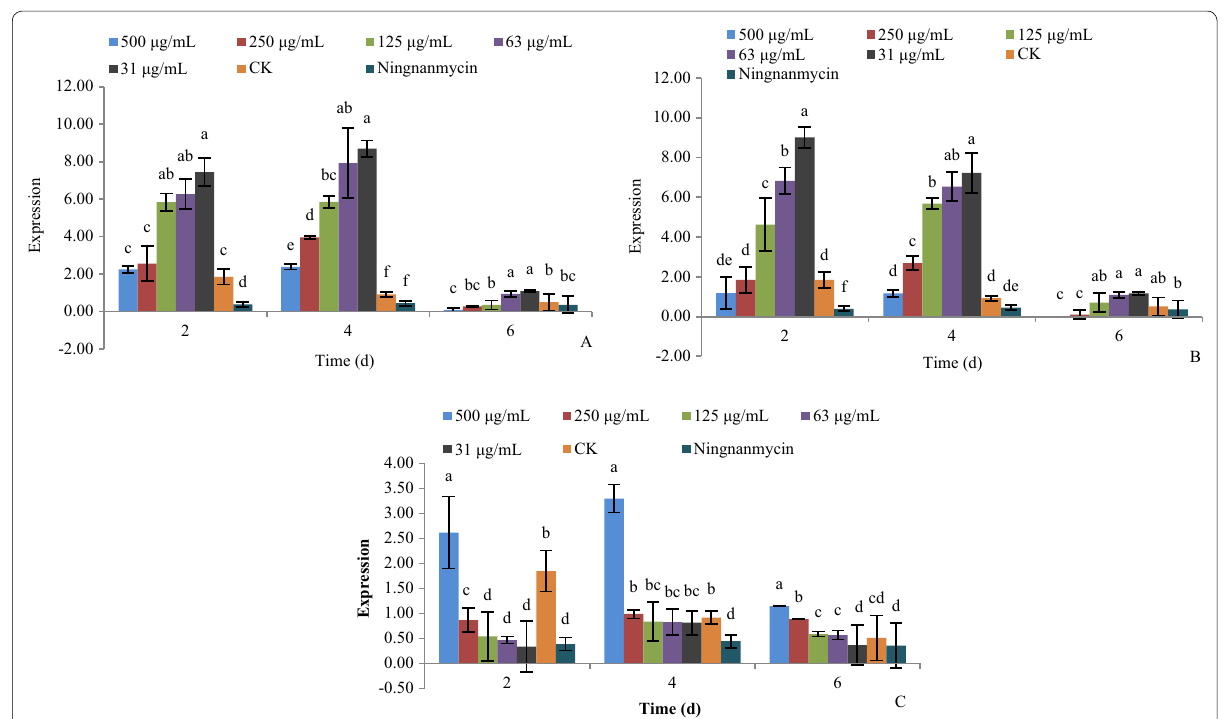
Fig. 8 The effect of active compounds 1 , 5 , and 9 on the expression of gene cullin - 1 . a Compound 1 ; b Compound 5 ; c Compound